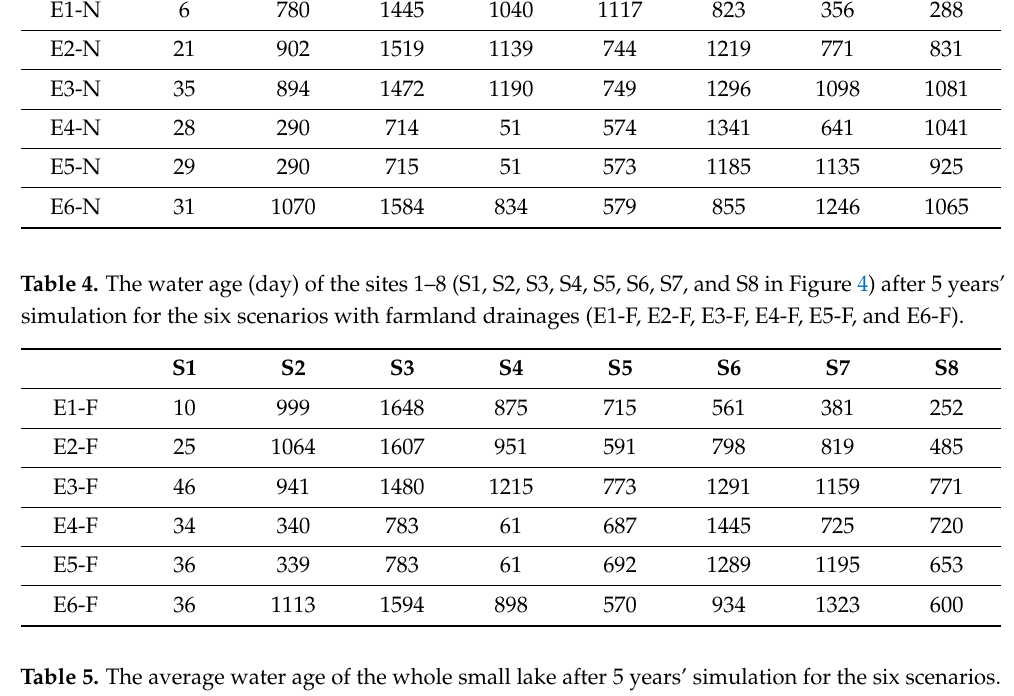
Table 5. The average water age of the whole small lake after 5 years’ simulation for the six scenarios. E1 E2 E3 E6 Without farmland drainages With farmland